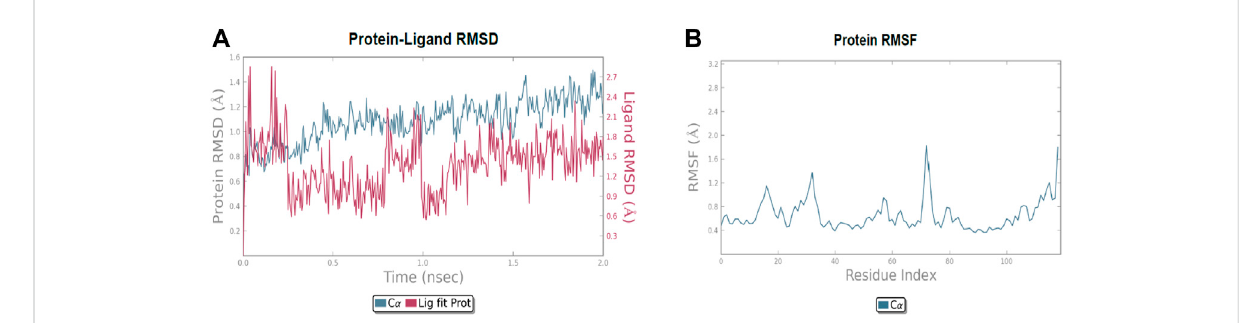
FIGURE 10 (A) RMSD of protein – ligand ( 10a 2OPZ) throughout 2ns and (B) RMSF of protein.